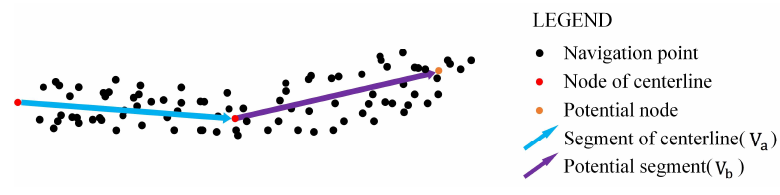
Figure 3. Determining a U-turn.